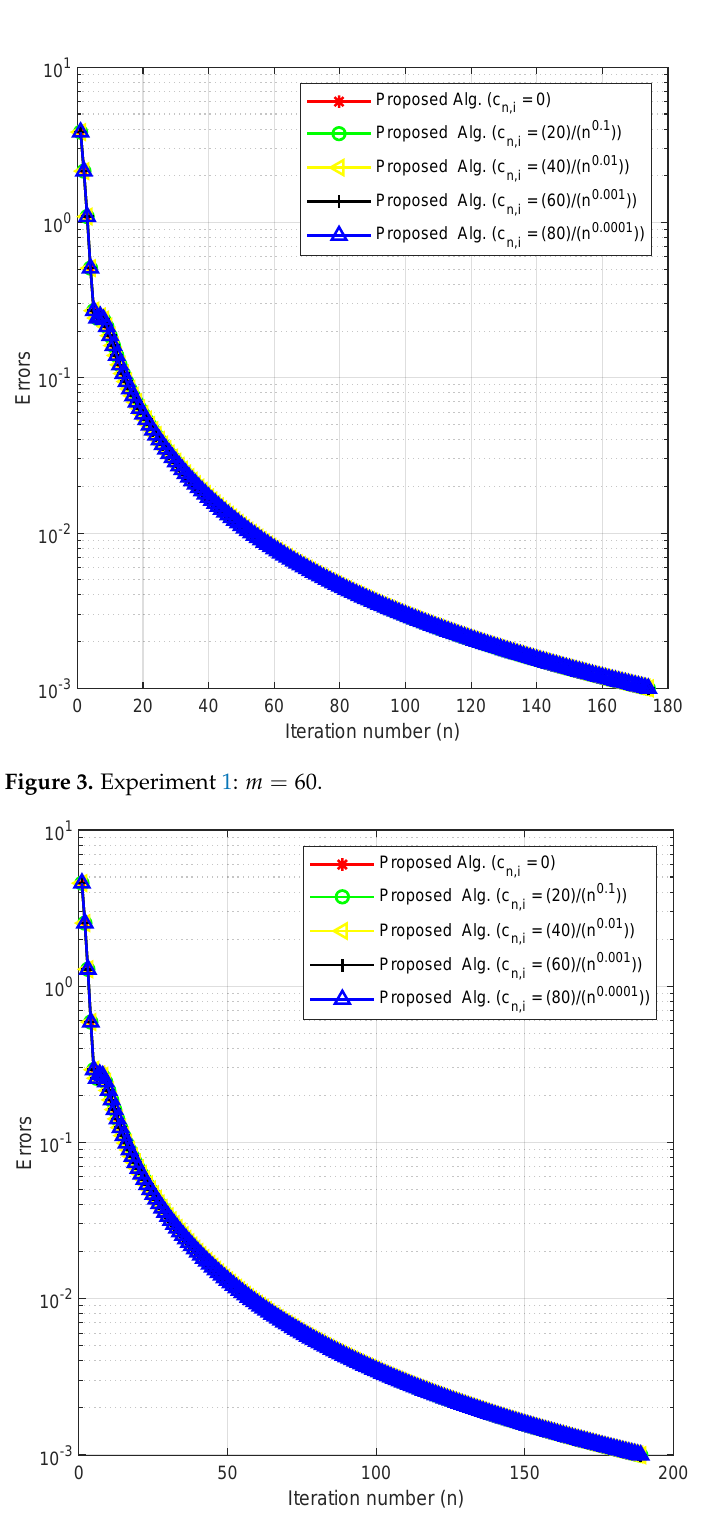
Figure 4. Experiment 1: m =